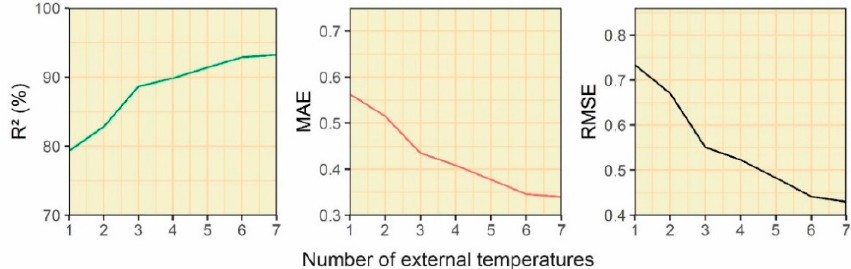
Figure 11. Influence of the number of the external temperatures used on the MLP model of A Gándara. Values obtained from the training of the model of the upper limit.